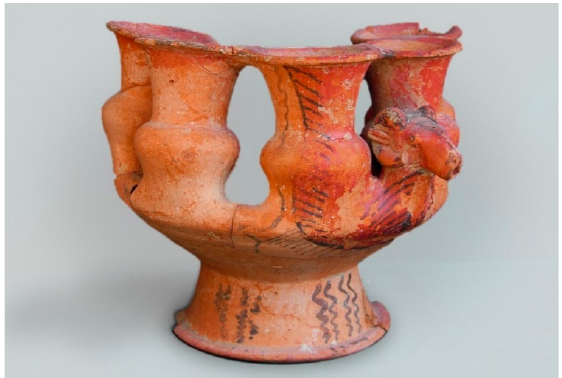
Figure 14. Head of a ram between cups (MGW inv. no. 3138); ceramic drinking vessel (kernos); ca. 650–600 BCE .